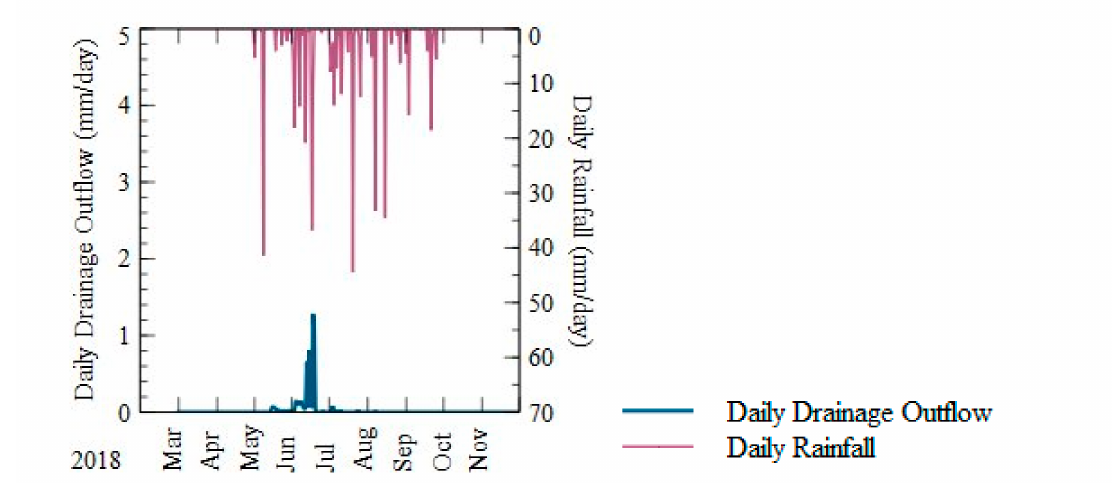
Figure 2. Daily rainfall and drainage outflow in 2012–2018 at the east sump of the study site in Richland County, ND.